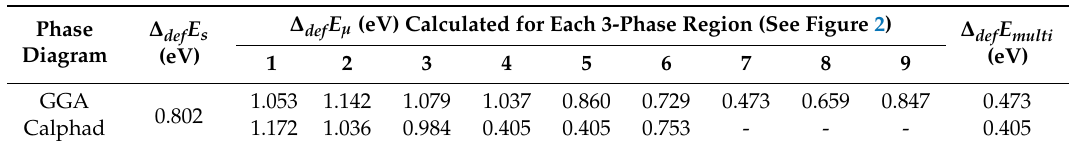
Table 1. Calculated energy of formation of non-charged Ni i defects in NiTiSn calculated within the GGA.